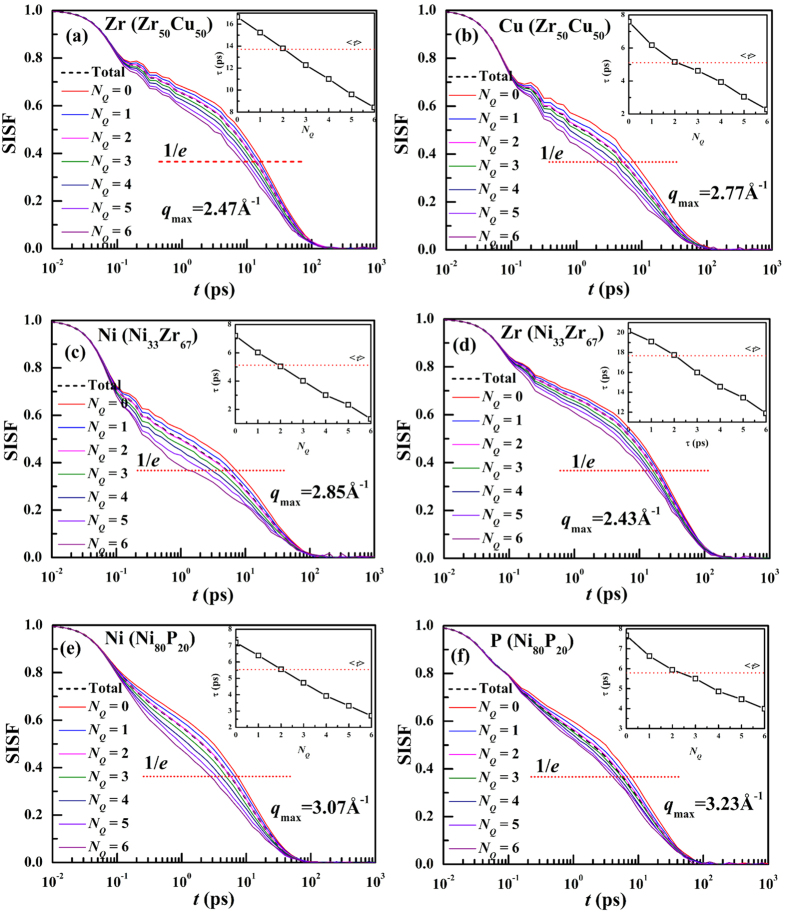
Self-intermediate scattering functions of (a) Zr and (b) Cu in Zr50Cu50, (c) Ni and (d) Zr in Ni33Zr67 as well as (e) Ni and (f) P in Ni80P20 with different NQ at the initial time at Tg + 150 K. Insets in (a~f) are the NQ-dependence of relaxation times and the dash line corresponds to the relaxation time for the element. 100 initial configurations were used to calculate SISFs.